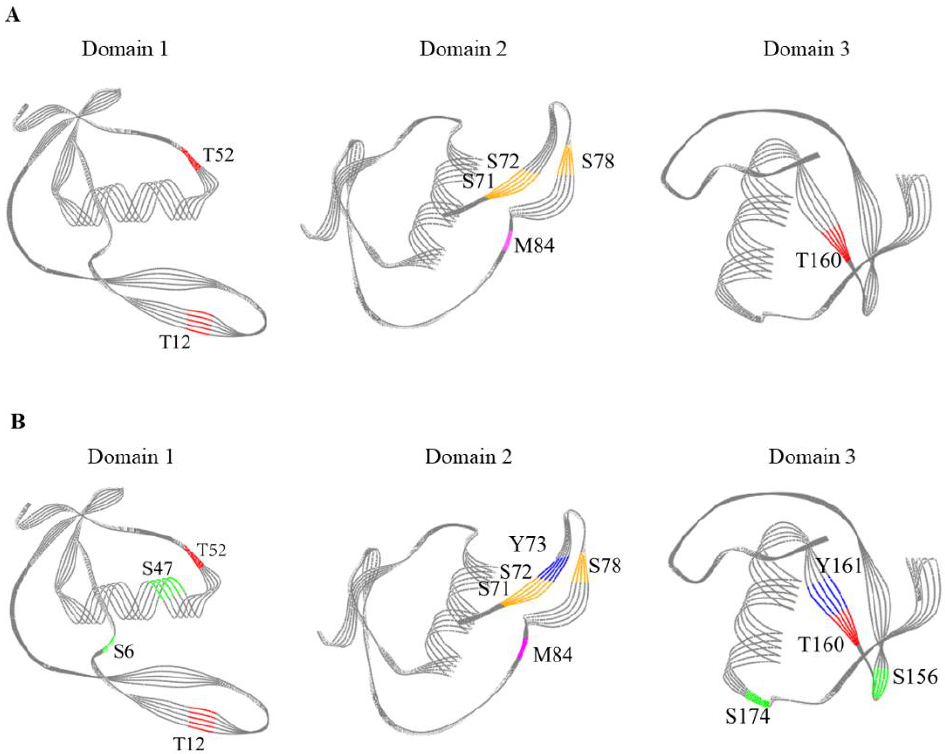
Figure 6. Modification sites in 3D diagrams of the three domains of SS-treated OVM. ( A ), 120 °C for 10 min and 140 °C for 10 min; ( B ), 200 °C for 10 min; purple, oxidation modification; blue, nitro modification; red, phosphorylation; orange, glygly modification; green, sulfo modification.